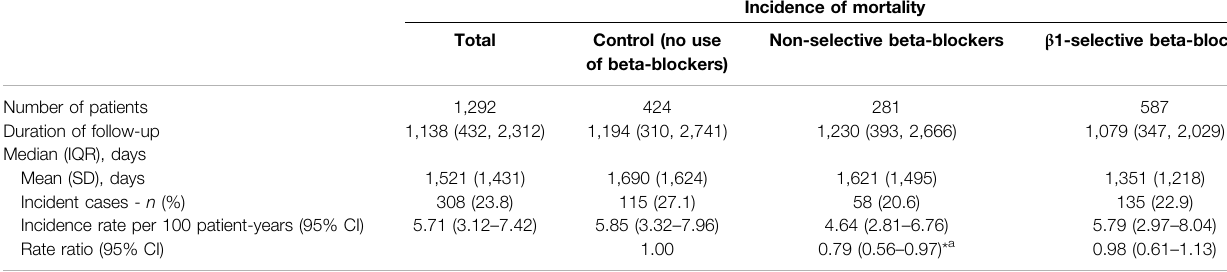
TABLE 1 | Incidence of mortality by prescriptions.